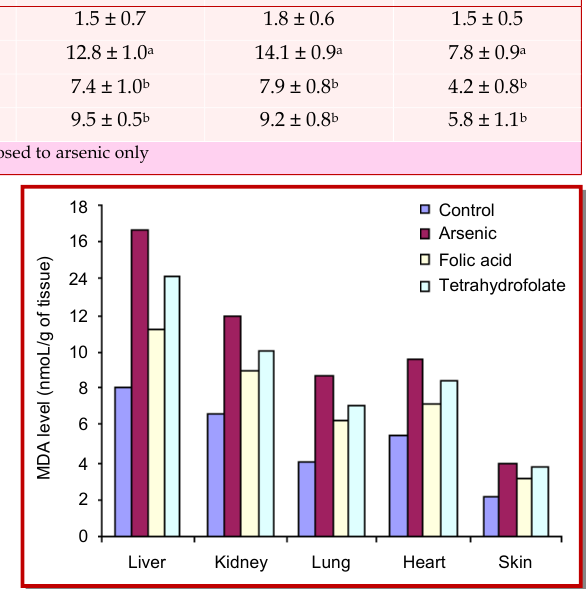
Figure 1: MDA levels in different tissues from rats given different